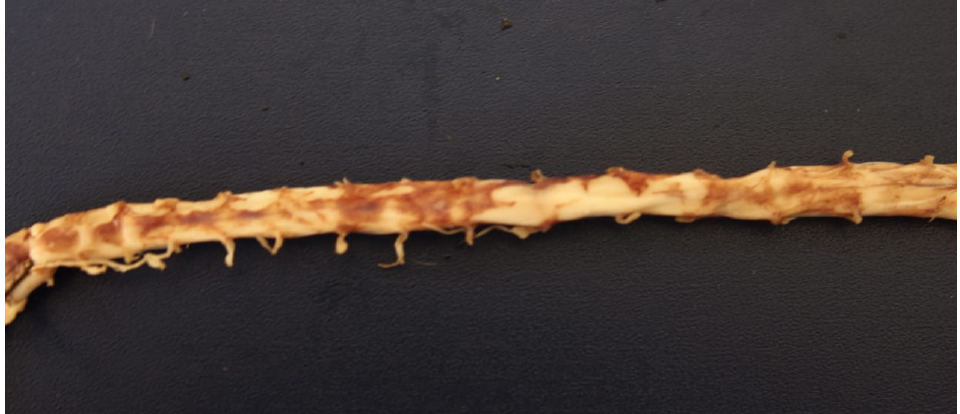
Figure 3. Mild to moderate foci of subarachnoid hemorrhages in the cervical and lumbar tract of the spinal cord of the kitten. Nematodes were also detected at the histological examination in the subarachnoid space of the brain and the spinal cord, which showed hemorrhages/congestion and cere- bral lymphocytic, eosinophilic, and neutrophilic infiltrates (Figure 4A,B). In the CNS, cross-sections of adult nematodes measuring between 62 and 94 µm in width were found (Figure 4C). Thin cuticle, pseudocoelom, celomatic musculature, and structures represent- ing the internal organs of the parasite were observed in some of the sections (Figure 4D).